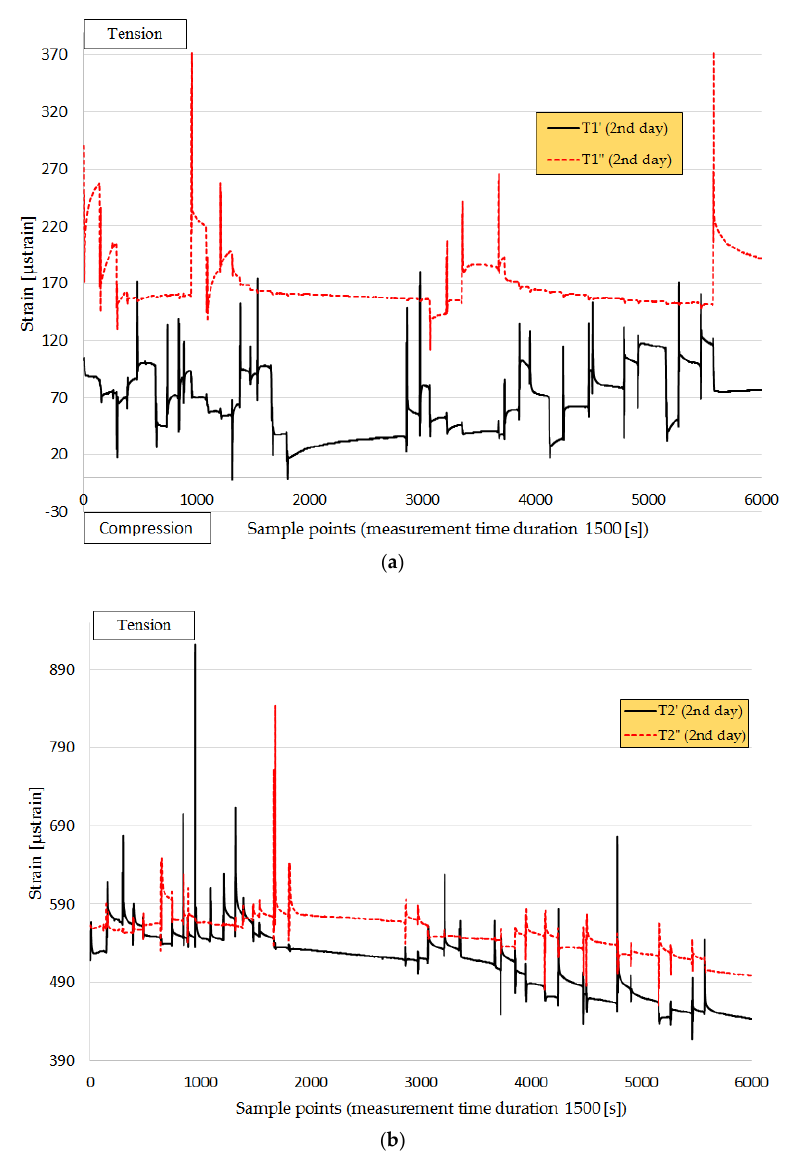
Figure 9. Strain values of sensors: ( a ) T1’ and T1’’ and ( b ) T2’ and T2’’ during the construction of CyPaTs asphalt pavement on the second day.